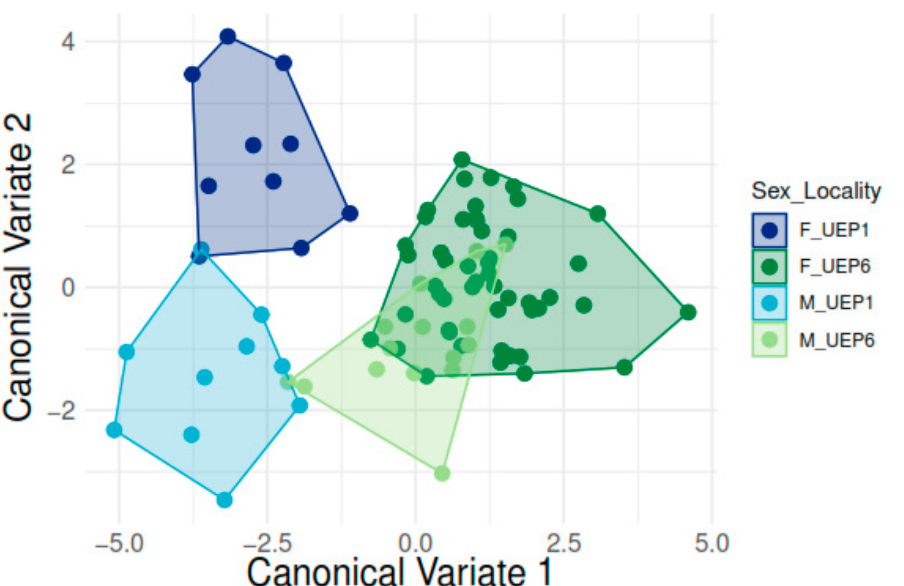
Figure 6. Canonical Variate Analysis using the classifier sex and locality. Colors represent the different population and their respective sex. Light blue: males of UEP1, light green: males of UEP6, dark blue: females of UEP1, and dark green: females of UEP6. Table 2. Permutation test based on Mahalanobis distances between populations and sexes of Pla- gioscion magdalenae , with female Ci é naga de capote (H/UEP1) and Ci é naga de Jobo (H/UEP6),